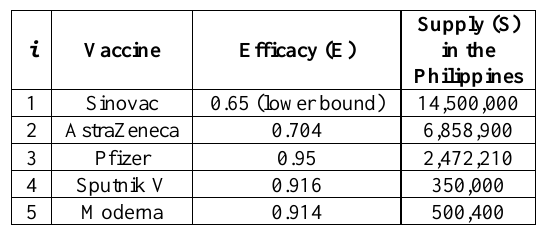
Table 2. Vaccine Efficacy and Vaccine Supply in the Philippines as of July 2021 Average Vaccine Efficacy = (∑ 𝑬 𝒊 ∗ 𝑺 𝒊 )/ ∑𝑺 𝒊 =𝟎. 𝟕𝟎𝟒